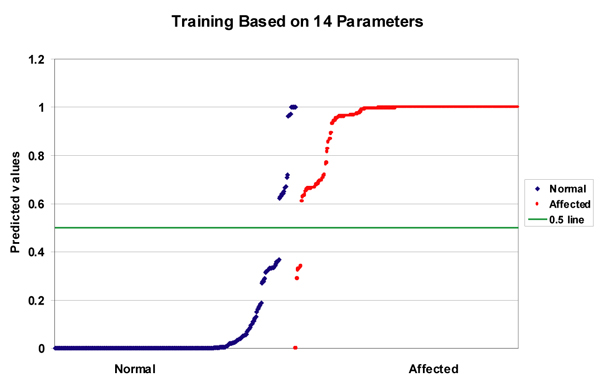
Predicted values and true diagnoses for 650 individuals: pruned neural network. Individuals diagnosed as normal are shown with blue diamonds, those diagnosed as alcoholics are shown with red circles. The best predictions are represented by values close to zero for normals and close to one fore affected individuals.